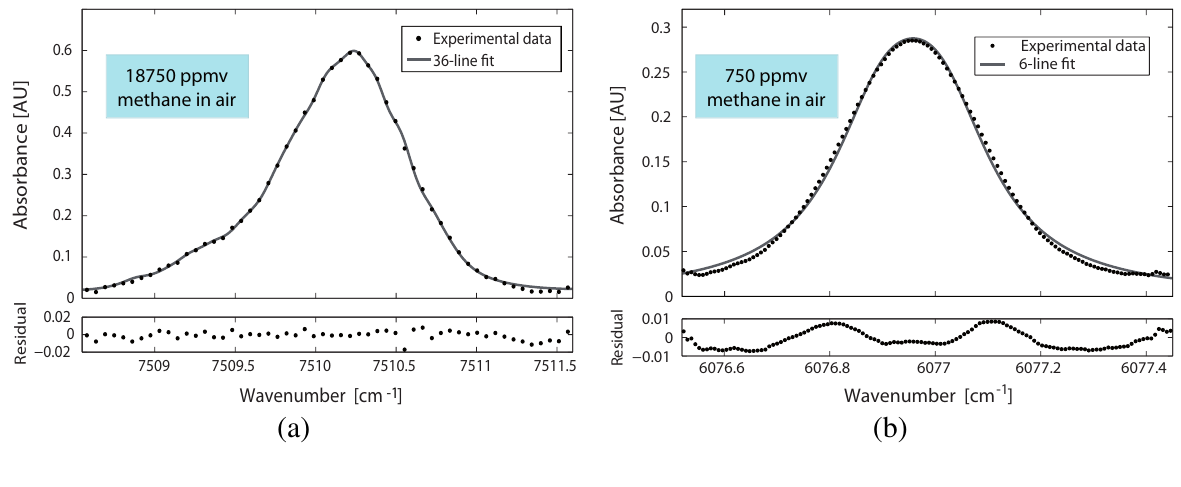
Figure 6. Analysis of the detection limit of methane: (Top) Experimental absorbance data and relative fit; (Bottom) Residuals of the fit. (a) 36-transition Lorentzian fit for the Q-branch at ν + 2 ν band at room temperature, relative pressure of 1 bar and methane concentration 2 3 of 18750 ppmv. (b) 6-transition Lorentzian fit for the R(6) manifold at 2 ν temperature, relative pressure of 1 bar and methane concentration of 750